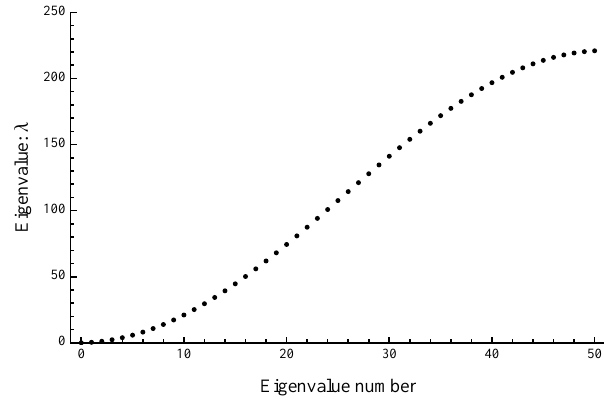
Fig. 3. Horizontal velocity component u (cid:0) z 0 (cid:1) for the case of basal in- clination θ = 18 ◦ and basal friction parameter η = 18, correspond- ing to a basal slip parameter γ = 10%. The exact solution, from Eq. (39), is shown by the solid line. Discrete points from numer- ical solutions with h = 0 . 02 for the standard Stokes and the refor- mulated Stokes cases are shown dotted. The two cases cannot be distinguished visually.